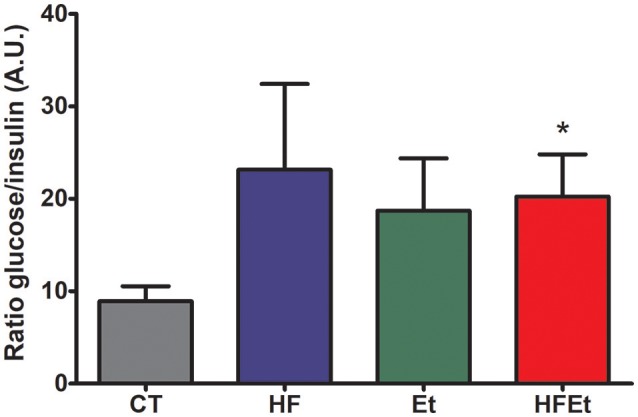
Ratio glycemia/insulinemia in rats after 6-week diet with either control (CT), high fructose (HF), ethanol (Et), or a mix diet (HFEt) and prior infusion of [1-13C]D-glucose. Glucose and insulin content were measured in a blood sample collected just before [1-13C]glucose infusion and after 6 weeks of diet to detect any disturbance in insulin and therefore glucose metabolism homeostasis at this time point. Values are mean ± SEM. *Statistical difference between CT and HFEt.